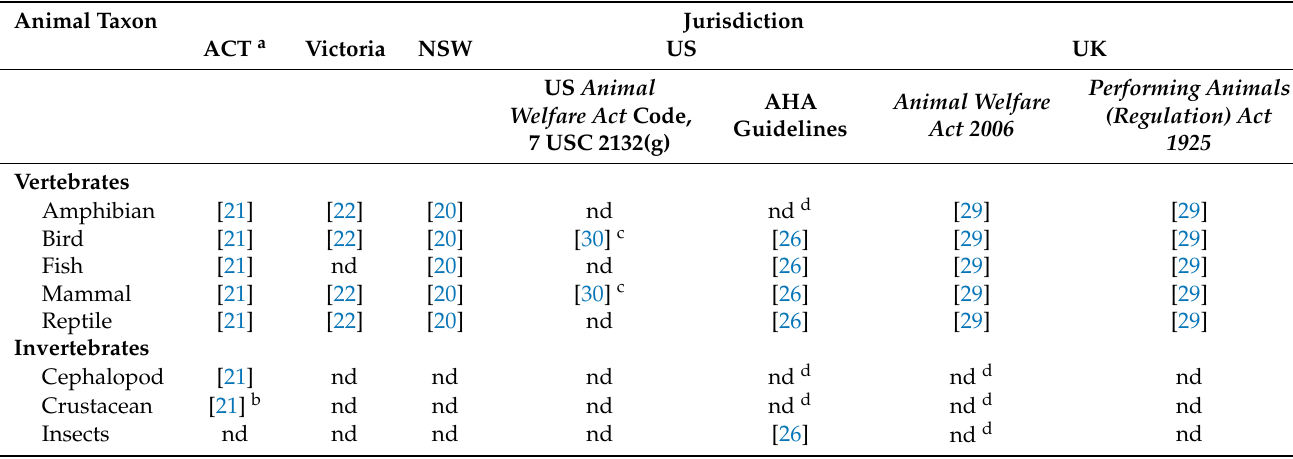
Table 1. Definition of non-human ‘animals’ under the relevant Animal Welfare Acts, Regulations, Guidelines, and CoPs for filmed media across